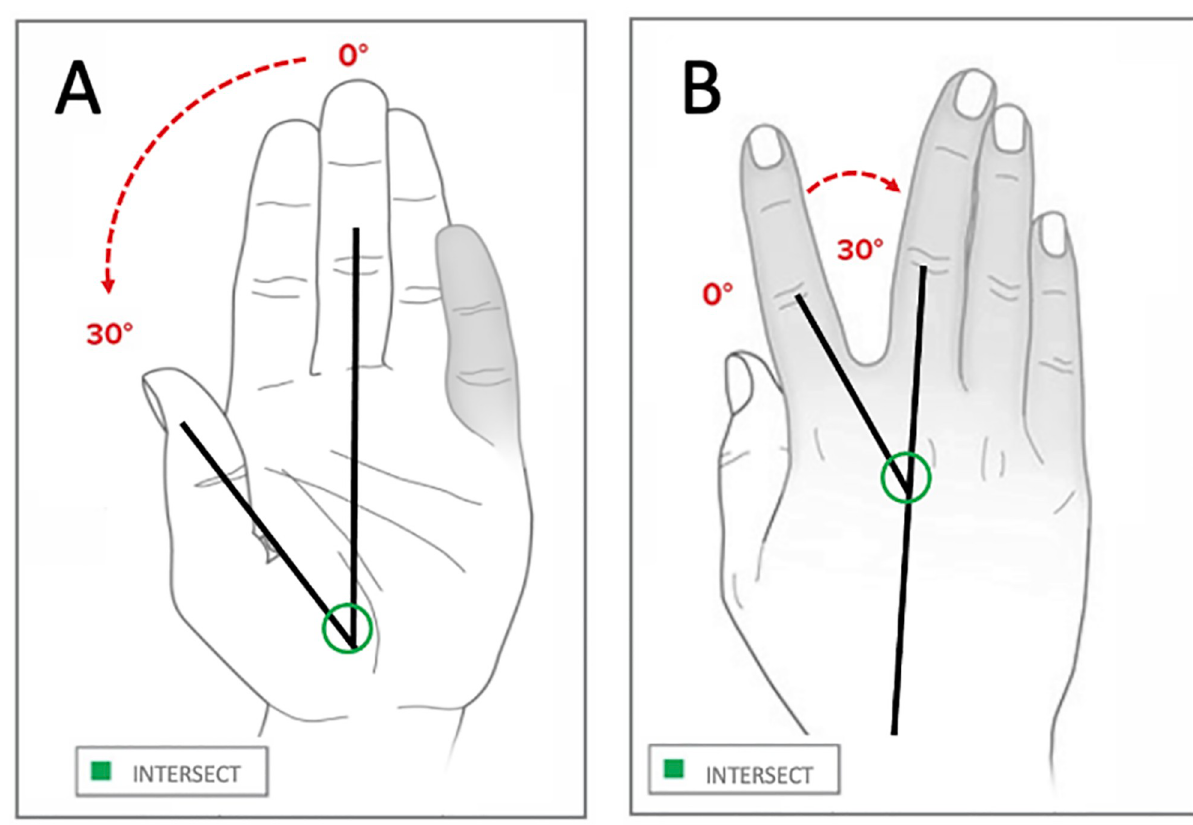
Fig 5. Abduction and adduction angles. Measured position for the finger intersect joint of the index finger (A), and of the thumb (B).